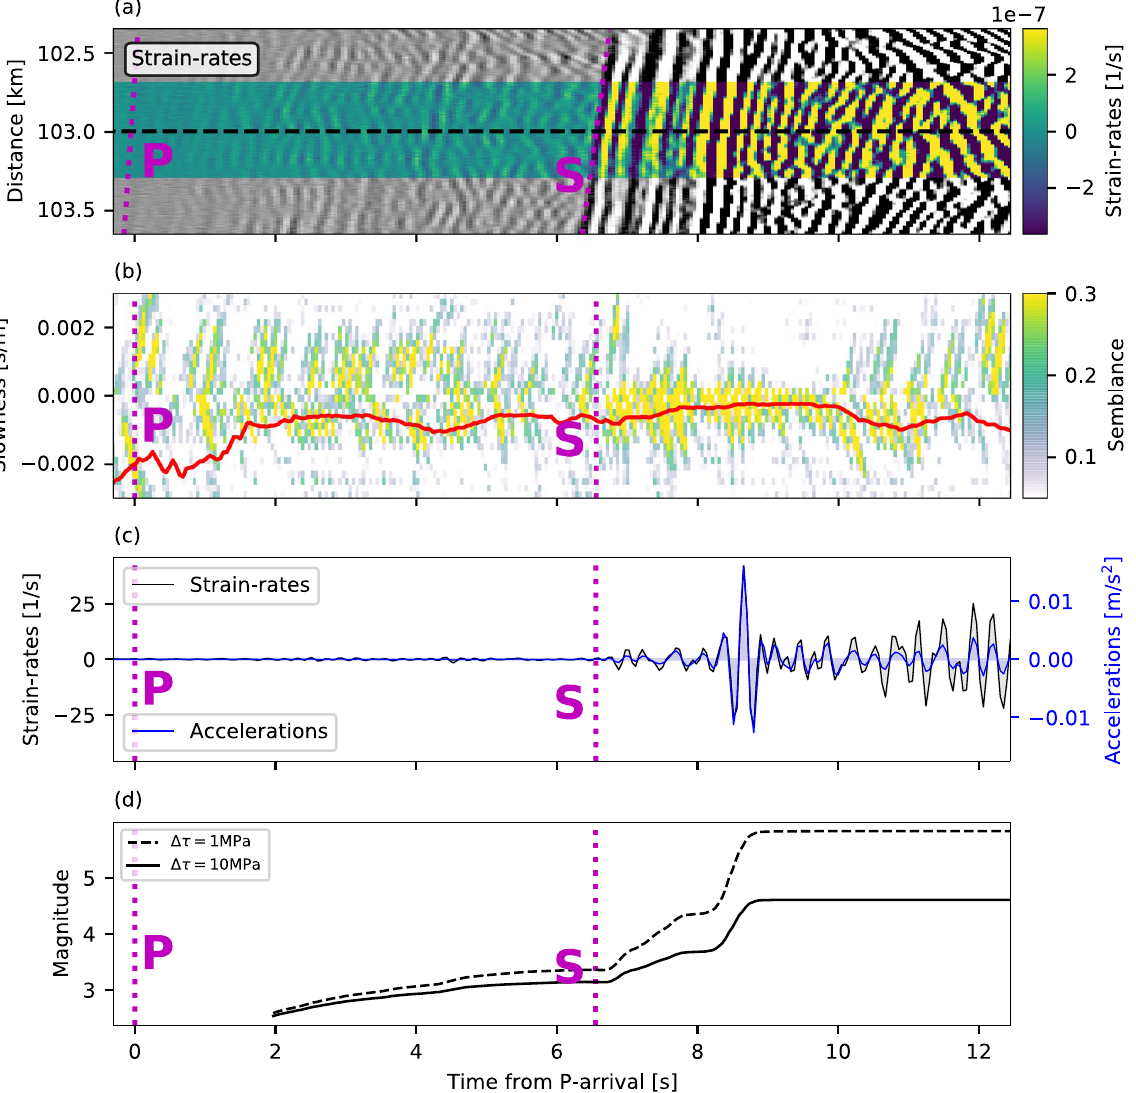
Figure 2. Strain-rates to ground accelerations conversion and magnitude estimation. a Strain-rates of a magnitude 3.8 earthquake recorded at a hypocentral distance of 60 km between 102.3 km and 103.6 km along a fiber offshore Chile. The fiber segment used for magnitude estimation is color-coded (102.7 km to 103.3 km). b Semblance as functions of apparent slowness and time from P-wave arrival for a reference DAS channel at 103 km from the interrogator (black dashed line in a ). Smoothed slowness (See Methods) is indicated by a red curve. c Strain-rates (black) and converted ground accelerations (blues) for the reference DAS channel. d Real-time magnitude evolution using stress drops of 1 MPa (dashed curve) and 10 MPa (solid curve). Manually picked P- and S-wave arrival times are indicated by magenta